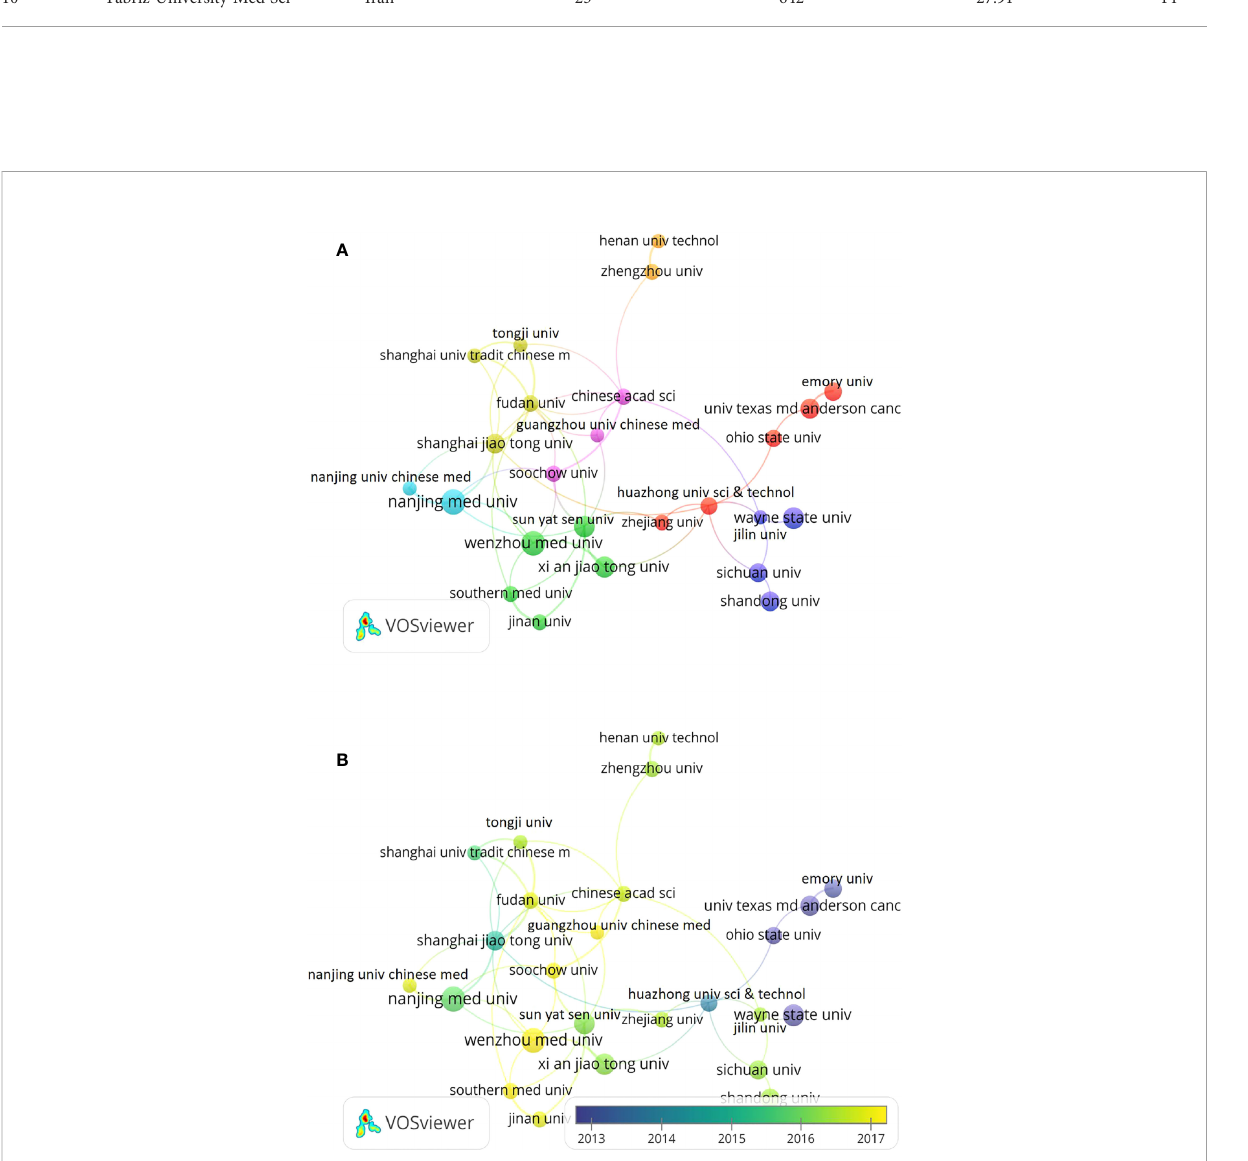
FIGURE 5 Cooperation networks between institutions based on VOSviewer. (A) Cooperation relationship chart of various institutions with network visualization. (B) Cooperation time chart of various institutions with network